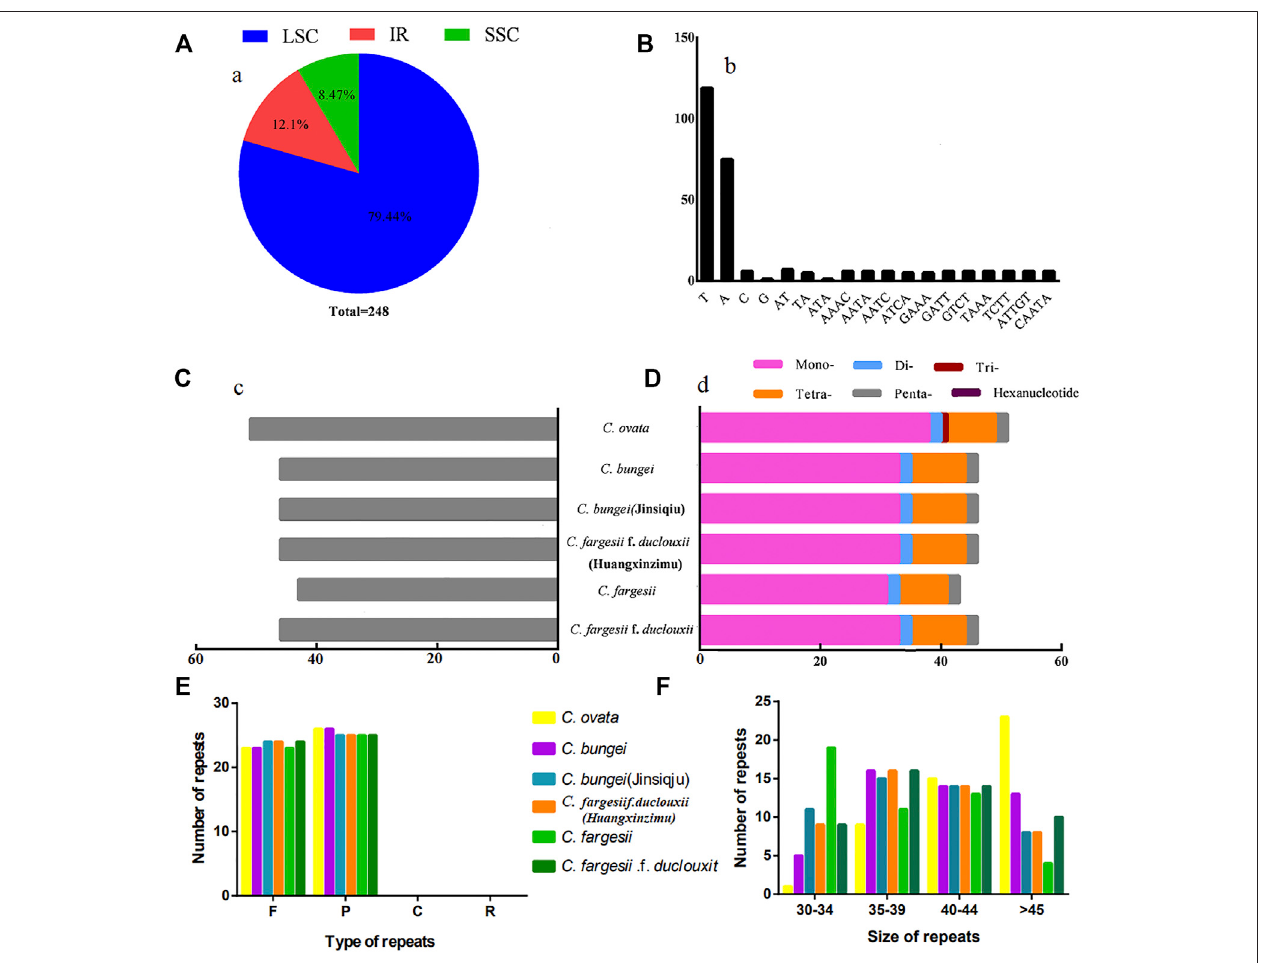
FIGURE 2 | Microsatellite and oligonucleotide repeat analyses. (A) Frequency of identi fi ed SSRs in LSC, IR, and SSC regions. (B) Frequency of identi fi ed SSR motifs in different repeat class types. (C) Number of SSRs detected in six chloroplast genomes. (D) Number of SSR types detected in six chloroplast genomes. (E) Comparison of the various types of oligonucleotide repeats. (F) Comparison of repeats based on